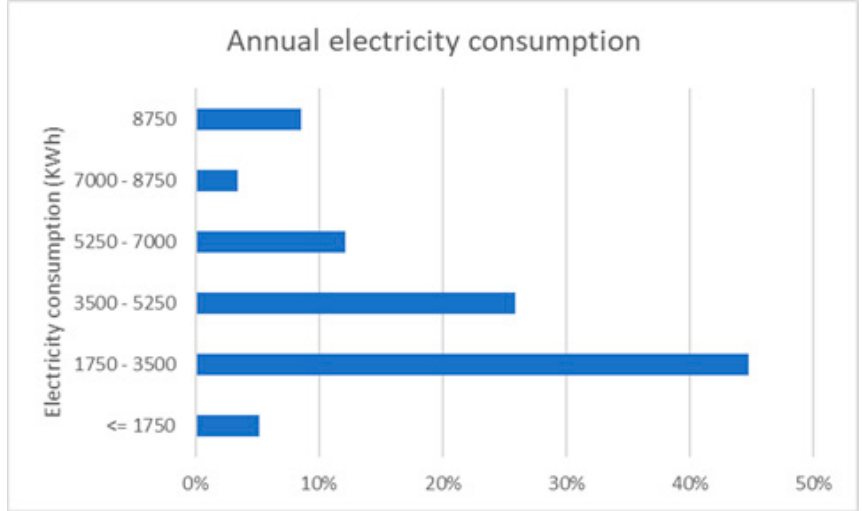
Figure 6. Annual electricity consumption based on electricity consumption monitoring. Annual electricity consumption varies by the property’s size, although not propor- tionally, as shown in Figure 7. Higher electricity consumption is observed in smaller (less than 70 m 2 ) and bigger houses (over 110 m 2 ), with no statistically significant differences occurring though.